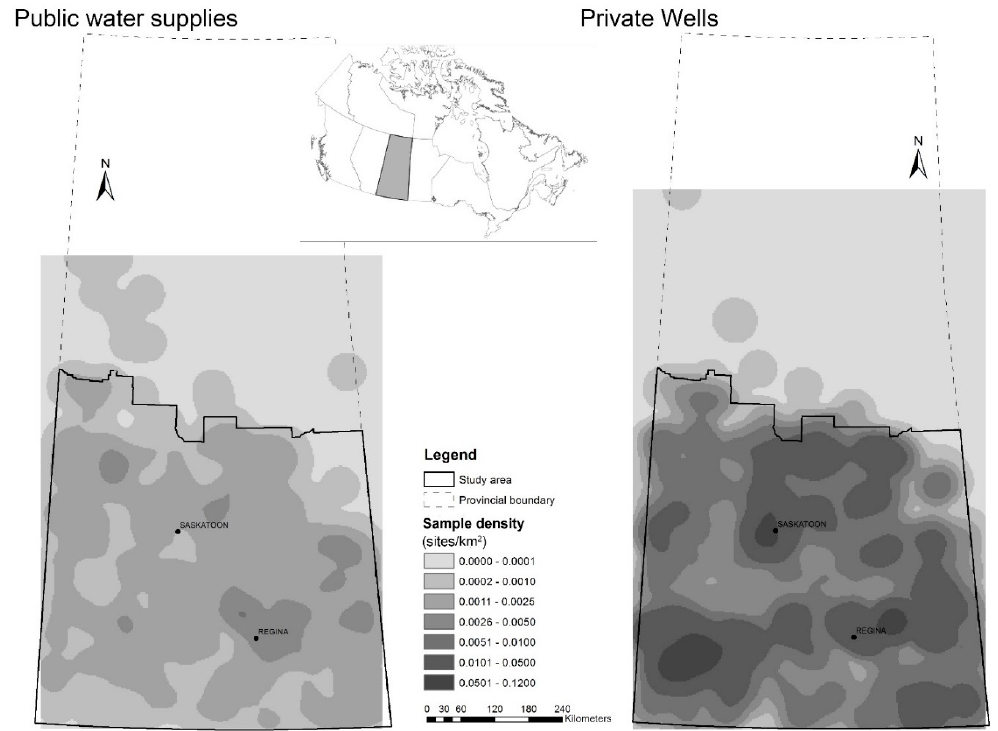
Figure 1. The density of sampling sites for: public water supplies ( left ); and private wells ( right ) across the province. The solid line indicates the boundary for the geostatistical analysis. Inset map shows location of the province of Saskatchewan within Canada.